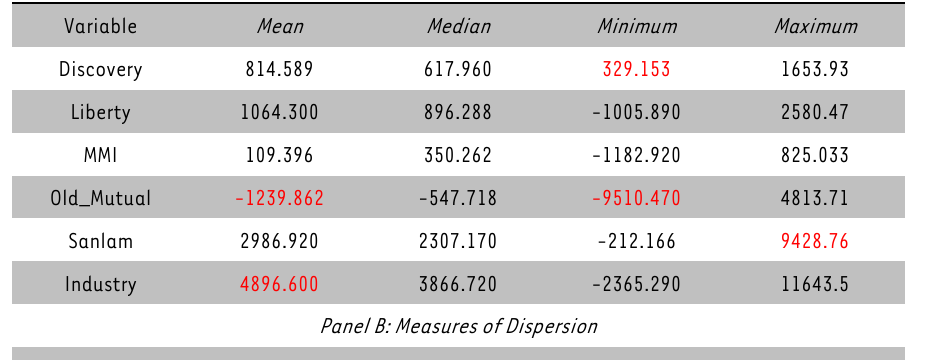
TABLE 2: Summary Statistics Panel A: Measures of Central